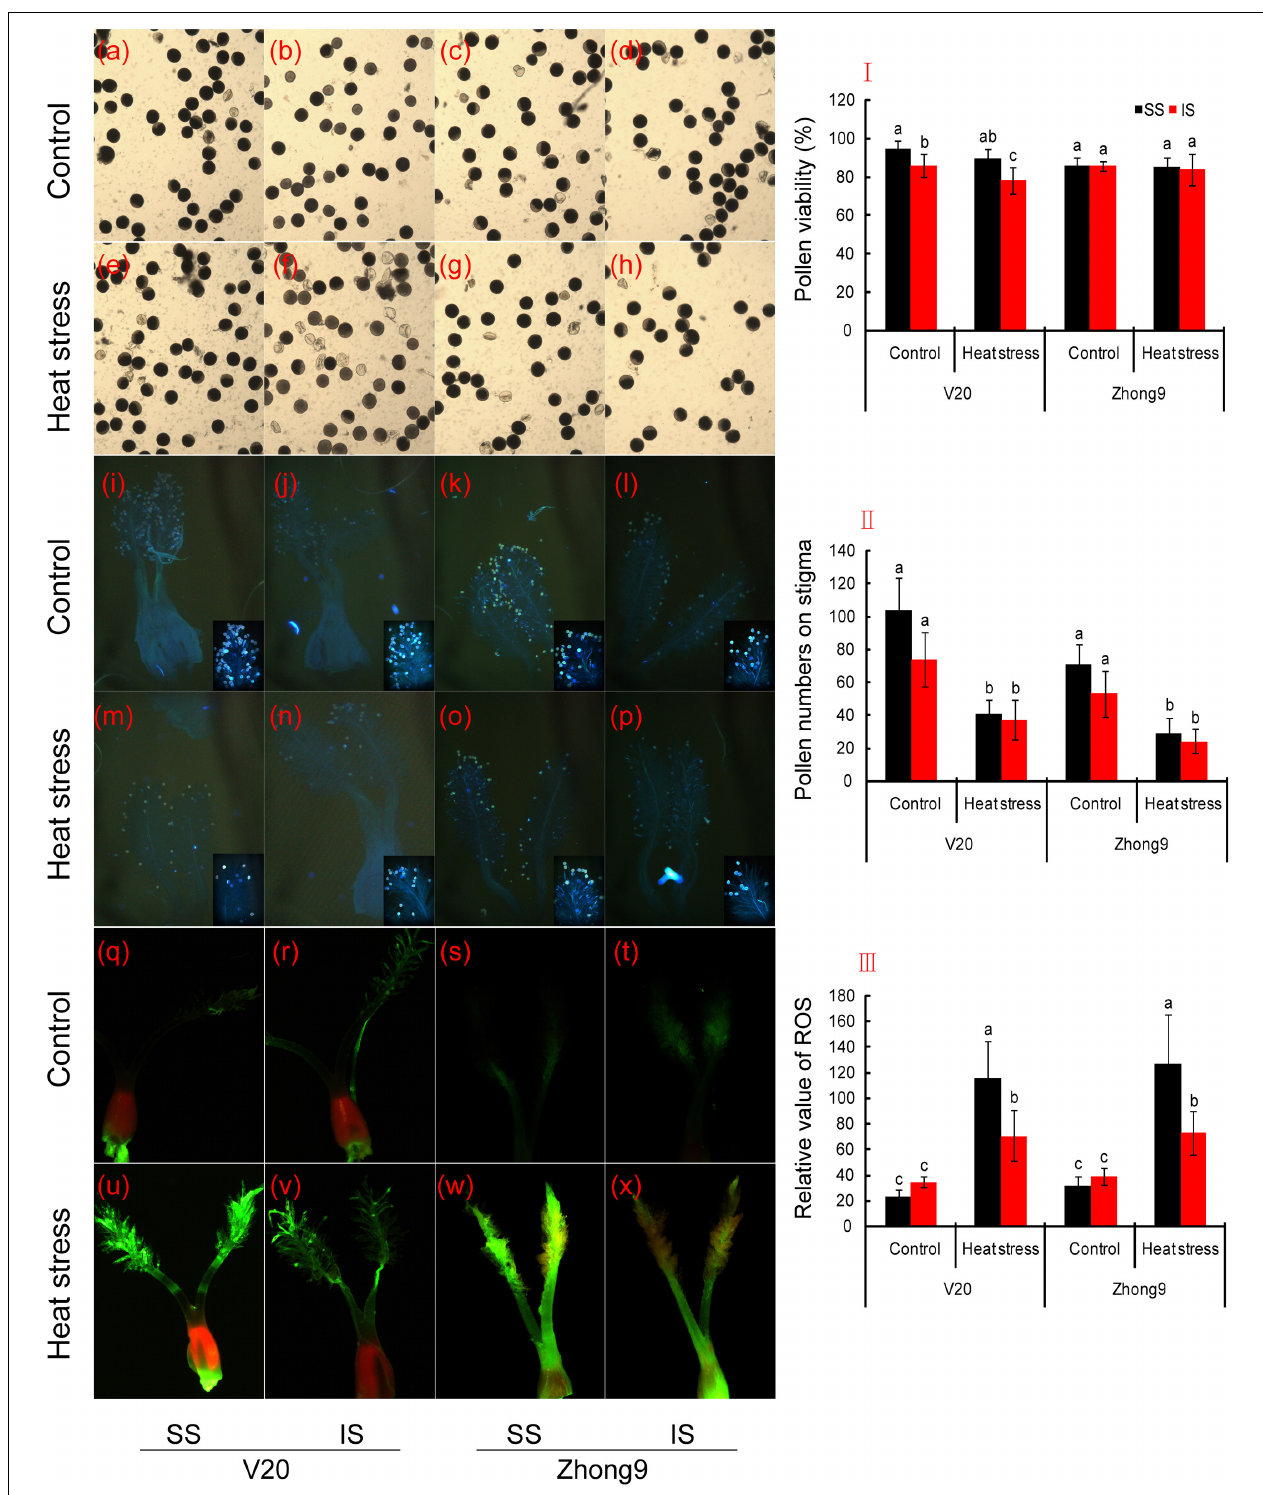
FIGURE 8 | Changes in the pollen viability, pollen number and pollen germinating on stigma, and pistil ROS between superior and inferior spikelets. SS and IS were indicated as superior spikelets and inferior spikelets, respectively. (a–d,I) were pollen viability, (i–p,II) was pollen numbers and pollen germinating on stigma, and (q–x,III) were pistil ROS. The data in the figures (I,II,III) were showed as the mean of 10 replicates. Vertical bars denote standard deviations ( n = 10). Different letters indicate significant differences between the superior spikelets and inferior spikelets in the same cultivar ( P < 0.05).